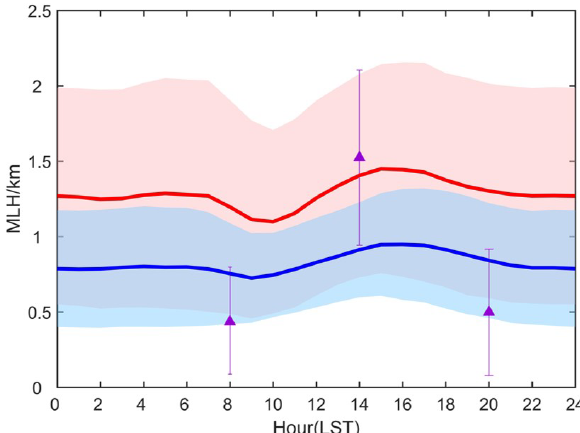
Figure 7. Diurnal cycles of the mixing layer height. The red line in- dicates the MLH L retrieved from lidar, and the blue line represents the MLH (cid:48) from lidar. The shaded areas show the standard devi- L ation of MLH L and MLH (cid:48) . Purple triangles indicate the MLH RS L averaged from routine RS data at 08:00 and 20:00 (LST) as well as from summer radiosonde at 14:00 (LST). The purple line indicates the standard deviation of MLH RS